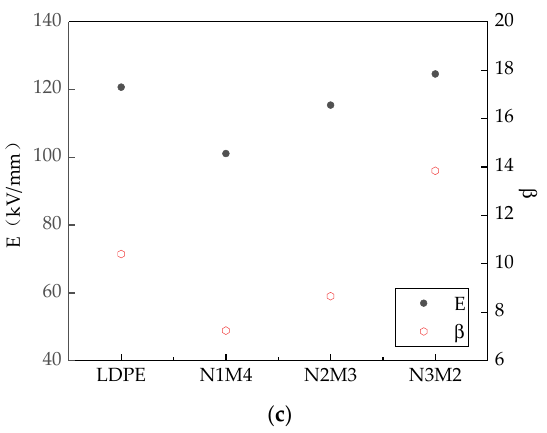
Figure 4. Weibull distribution parameters changes of three samples: ( a ) Nano ZnO/LDPE composites; ( b ) micro ZnO/LDPE composites; ( c ) micro-nano ZnO/LDPE composites.